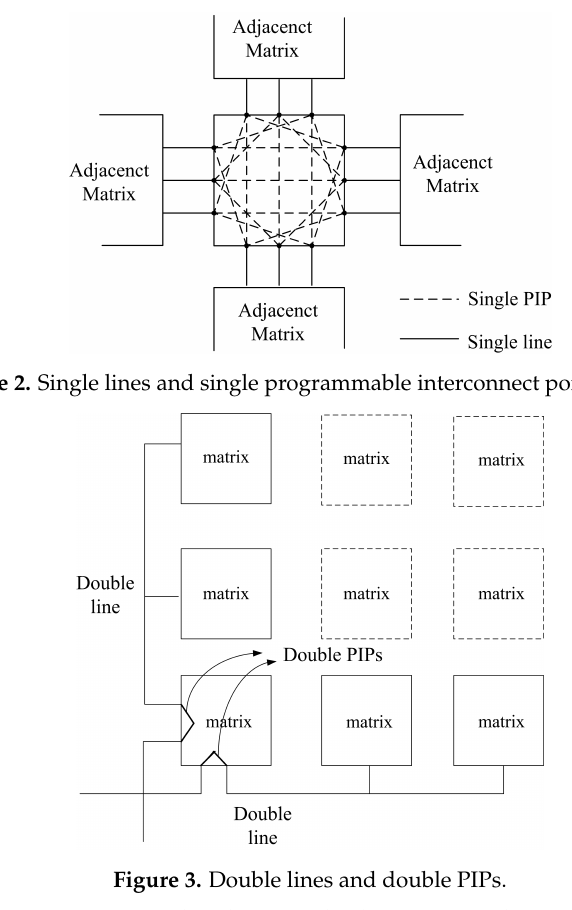
Figure 1. Typical island-style field programmable gate array (FPGA) architecture.